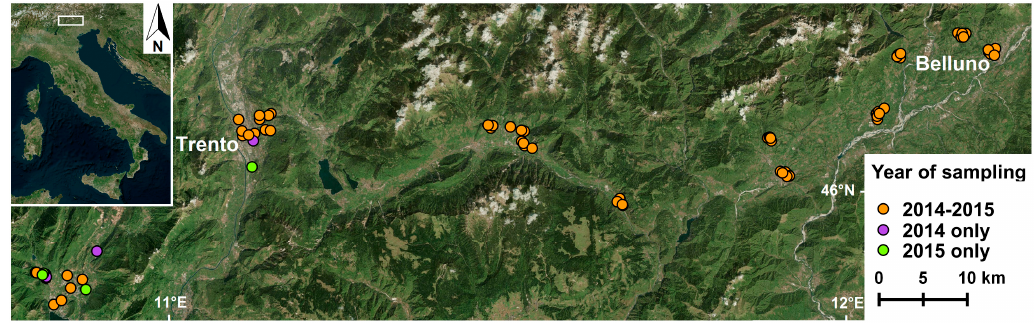
Figure 1. Trapping locations with BG-sentinel traps baited with BG lures and CO 2 . The different colours indicate the year(s) of sampling (2014 and/or 2015) for each sampling location (Microsoft Bing Aerial map).